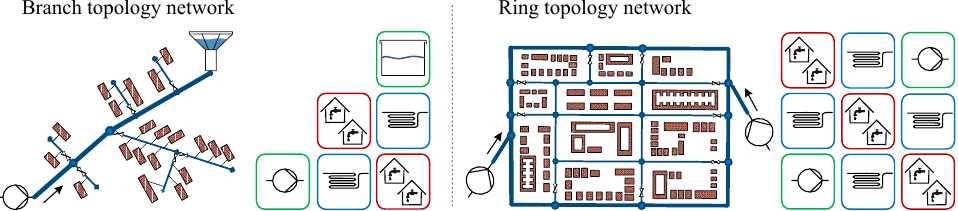
Figure 5. ( Left ): Scheme of a standard branched topology and its laboratory equivalent. ( Right ): Scheme of a standard ring topology and its laboratory